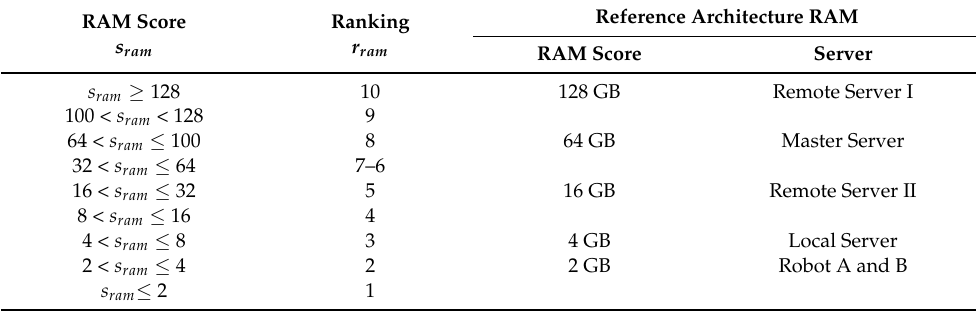
Table 2. Proposed RAM